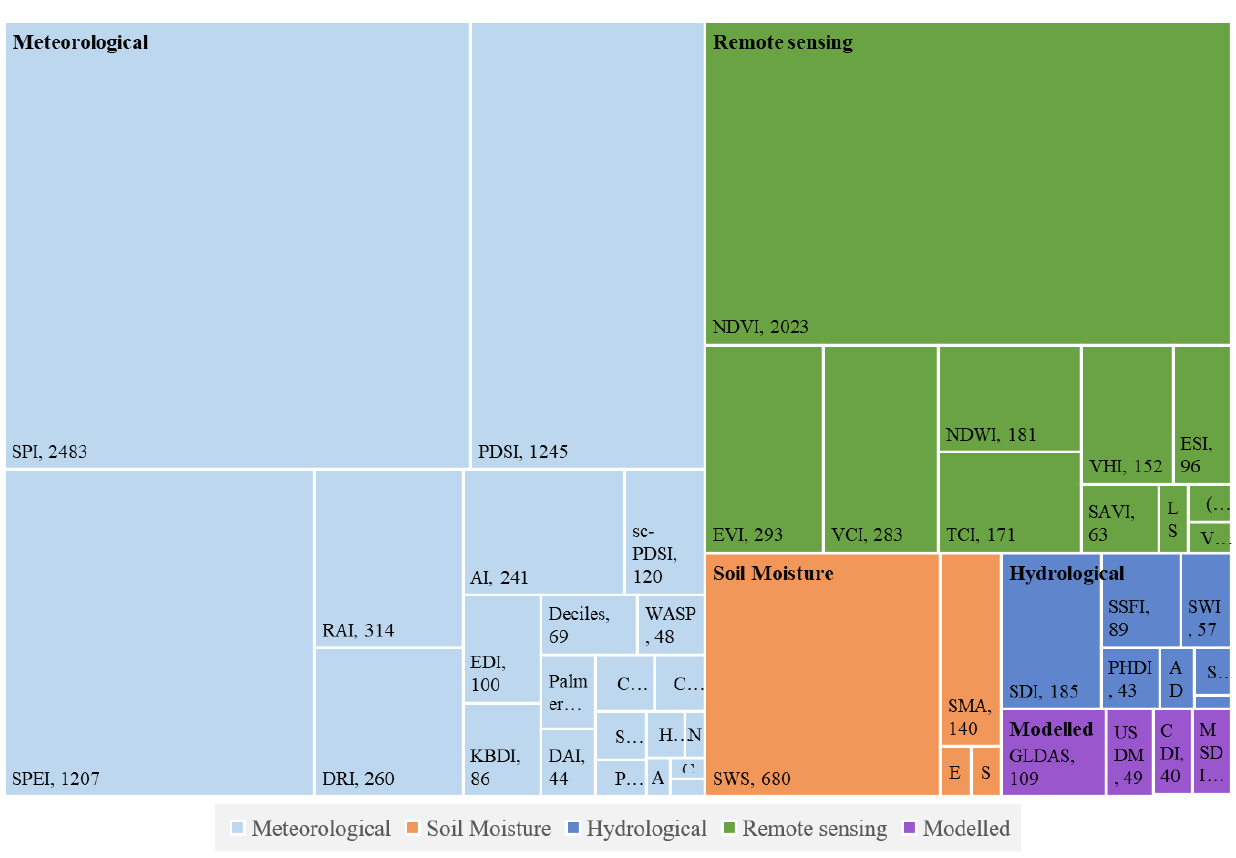
Figure 2. Types of droughts and DIs based on 11,291 documents.